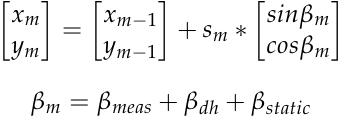
Figure 2. Motion model diagram of the target, where 𝑇